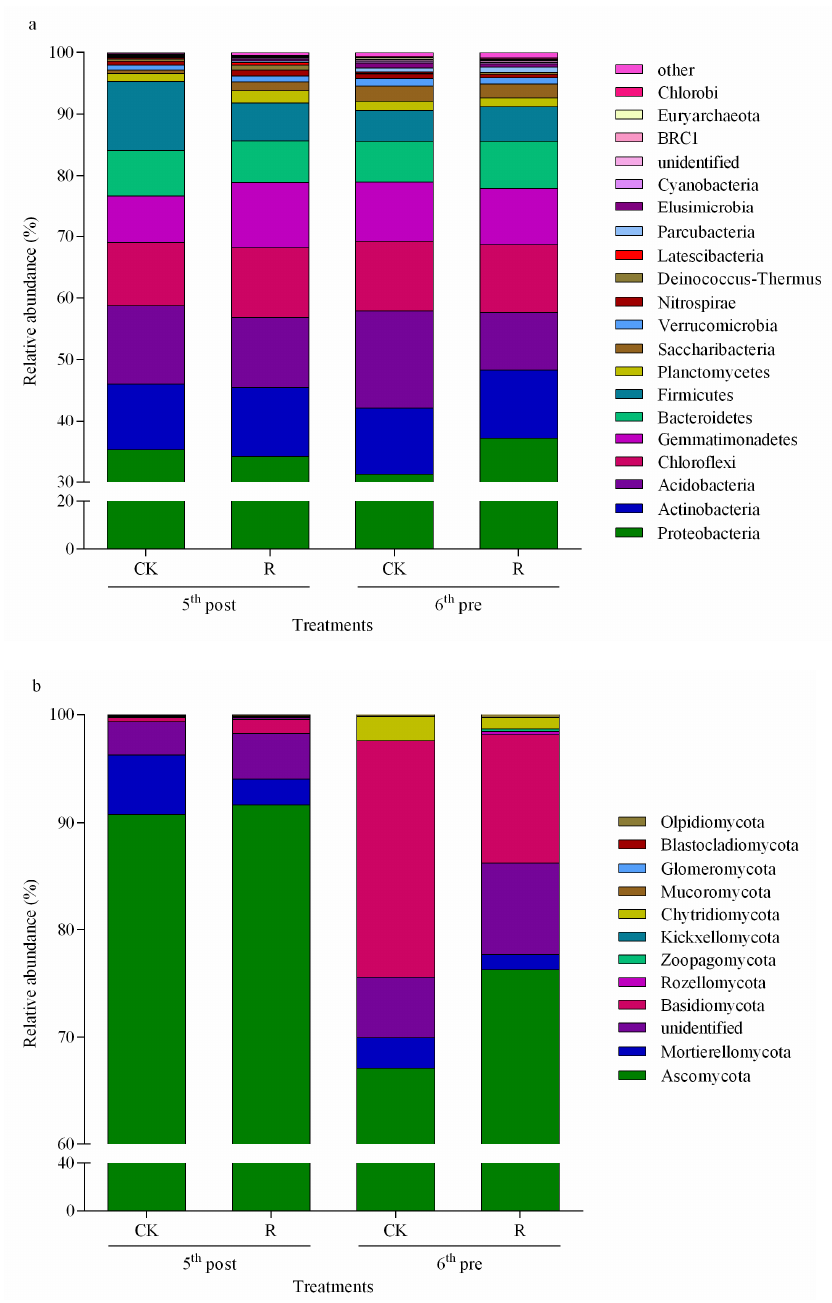
Figure 1. The microbial communities and the relative abundances of microbial phyla (( a ) for bacteria, ( b ) for fungi). CK, the non-vegetable residue treatment; R, the vegetable residue treatment; pre, the pre-returning stage; post, the post-returning stage; number 5 and 6, the times of in situ vegetable residue return.